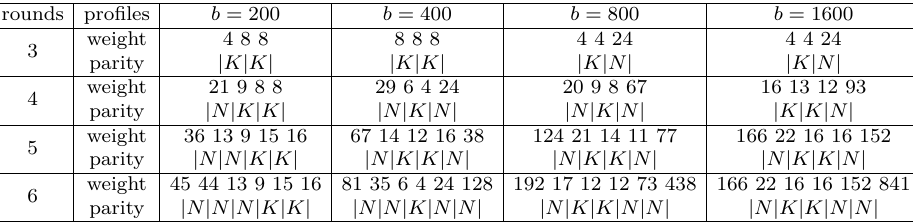
Figure 8: Number of all 3-round trail cores with weight T 3 . Table 3: Lightest trails found for different variants of Keccak - f